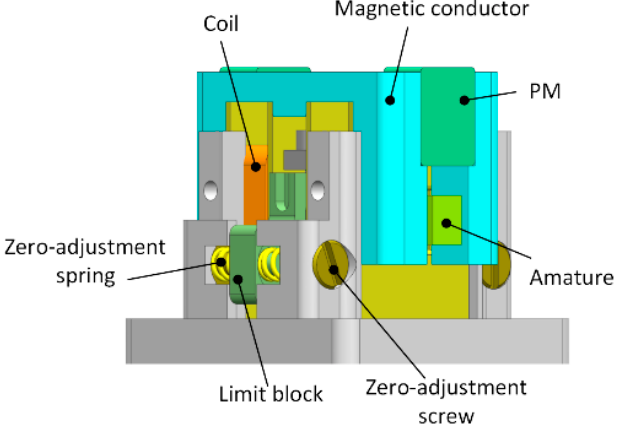
Figure 4. The structure diagram of moving iron torque motor.